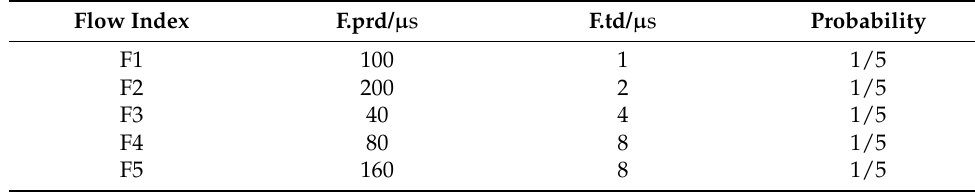
Figure 4. Synthetic topology test cases. ( a ) A small ring topology. ( b ) A small mesh topology. ( c ) A medium ring topology. ( d ) A medium mesh topology. Table 2. Test group 1 of candidate flows.